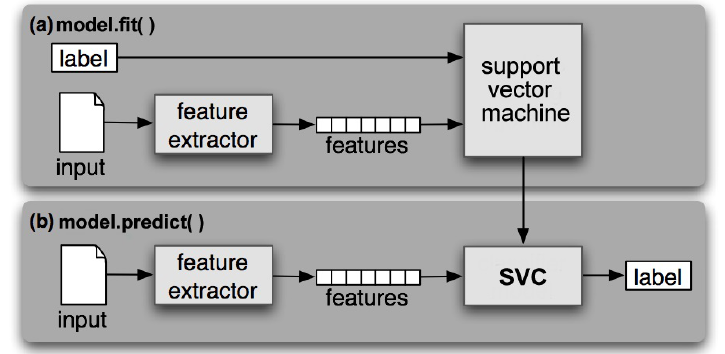
Figure 7. KLSVM’s training and prediction model. The inputs are the pre-processed packet